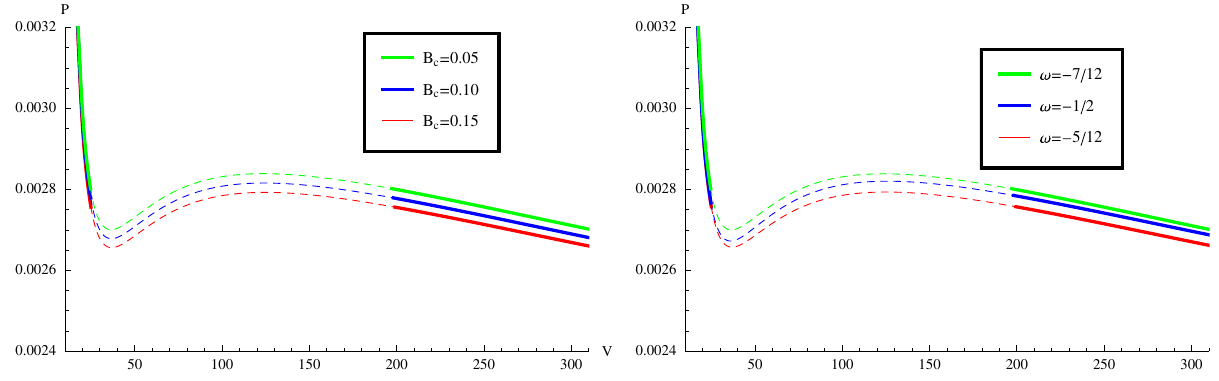
Fig. 2 The simulated phase transition and the boundary of a two-phase coexistence on the base of isotherms in the P – V diagram for charged anti-de Sitter black holes with differential B c and ω . The left figure shows Q = 1 ,ω = − 1 / 2, the right figure Q = 1 , B c = 0 . 1